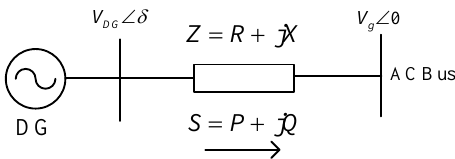
Figure 3. Simplified diagram of a DG connected to the AC